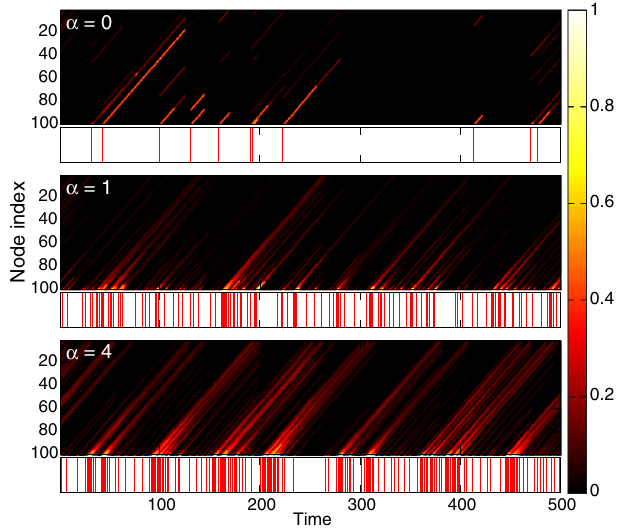
FIG. 2. Space-time evolution for fixed-size networks of N ¼ 100 nodes. Each matrix element ( i , t ) represents the clustering ð t Þ of node i at time t . Nodes are indexed from oldest ( i ¼ 1 ) to c i youngest ( i ¼ N ). At each time step, a new node is injected and the oldest node removed such that the time course of an indi- vidual node forms a diagonal across the matrix. Below each matrix is a spike train denoting injections of high-clustering nodes. As (cid:1) increases, the clustering coefficients of individual nodes persist for longer times and the arrivals of high-clustering nodes become increasingly temporally